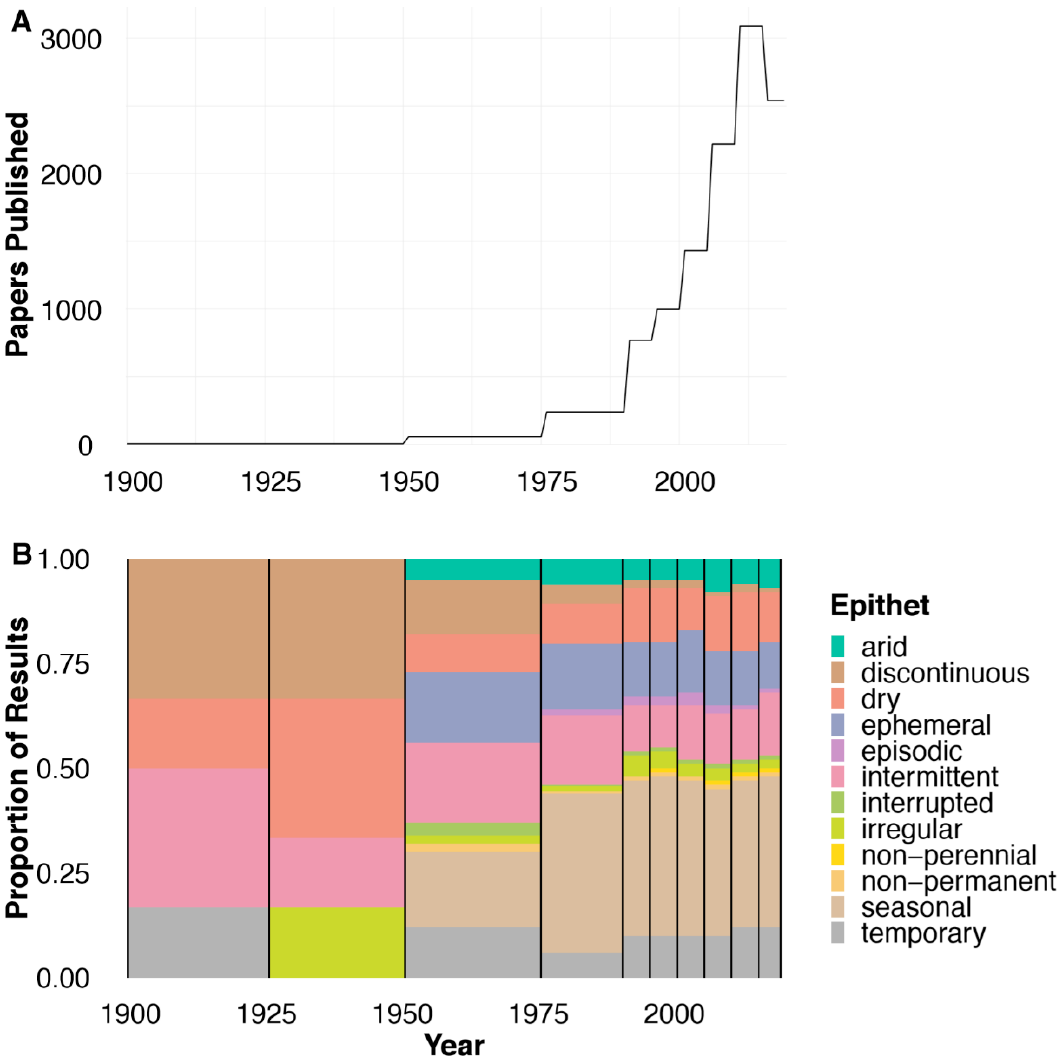
Figure 3. Number of total papers published ( A ) and proportion of papers published under different epithets ( B ) over time frames. Note the large jump in publication rates after 1990, and the steady increase until 2016. Papers from all 12 epithets are published between 1996 and 2000, though “non-perennial” does not appear in 2001–2005, all 12 are again represented in results from 2006 onward.